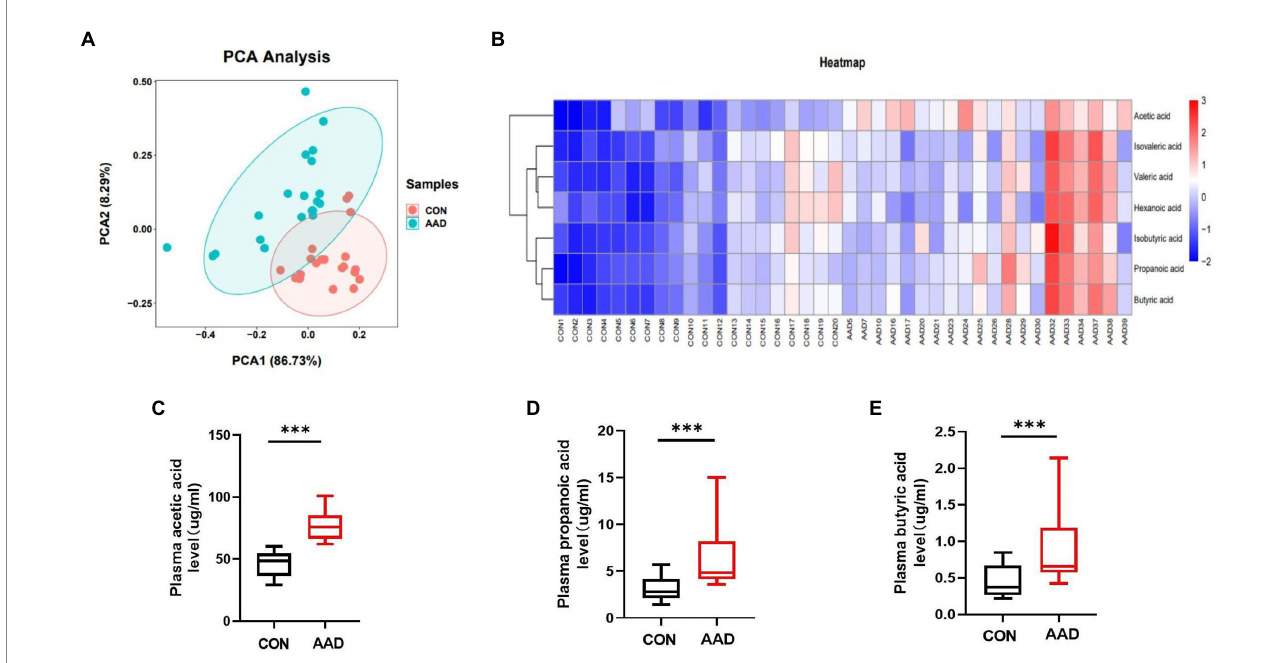
FIGURE 4 Comparison of plasma SCFAs between patients with AAD and healthy controls. (A) Plasma principal component analysis. (B) Heatmap clustering. (C) Box plots show plasma acetic acid. (D) Propanoic acid. (E) Butyric acid interquartile spacing and median between the two groups. The comparisons between